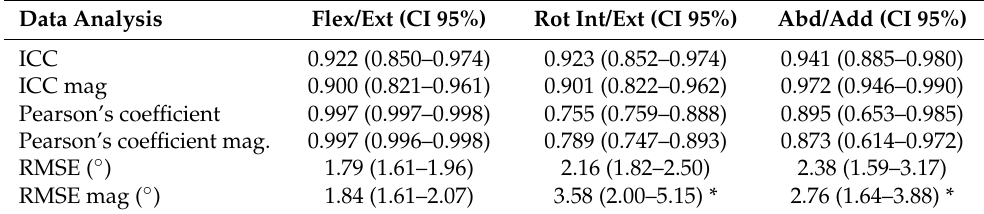
Table 2. The intraclass reliability and validation of the IMU system. ICC values were assessed on the RoM of the gait cycle. The difference between the IMUs and MIMUs was highlighted by paired t -tests (* p -value <